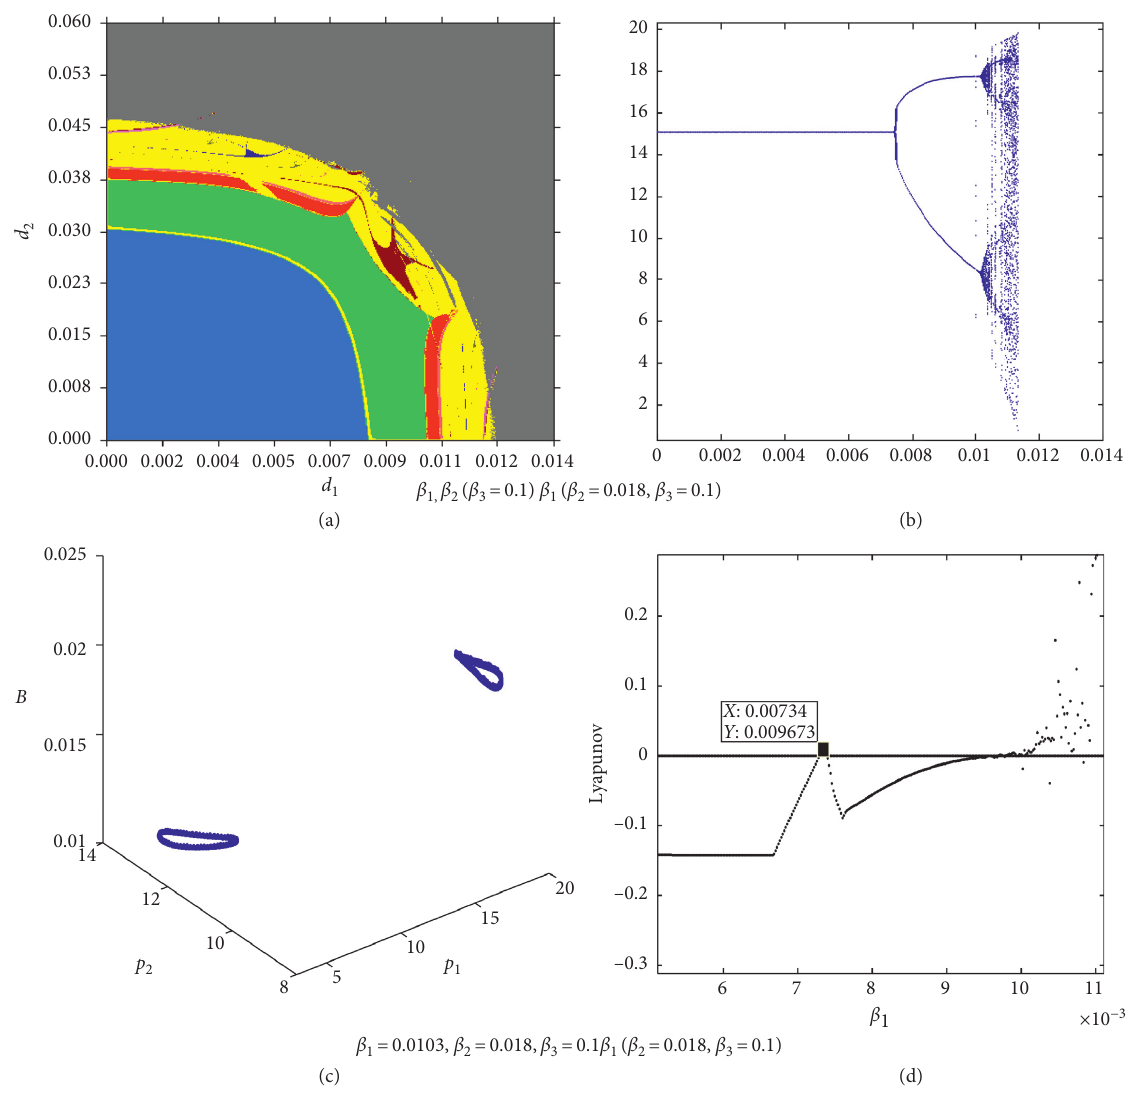
Figure 7: Two-dimensional bifurcation diagrams of the